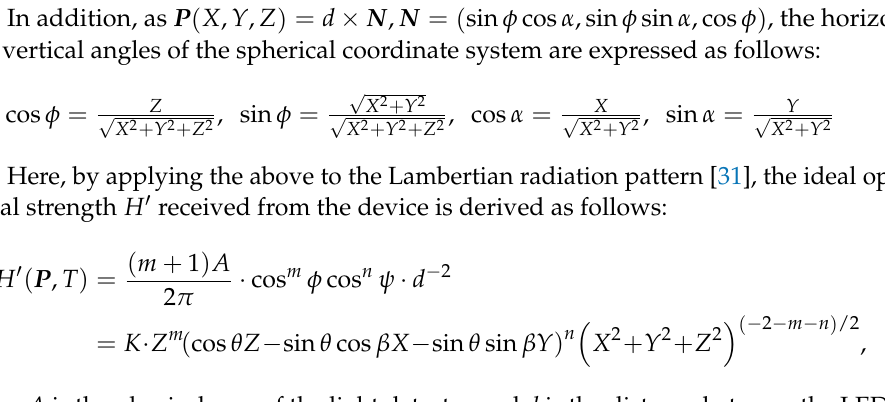
Figure 2. Optical system representation in 3D